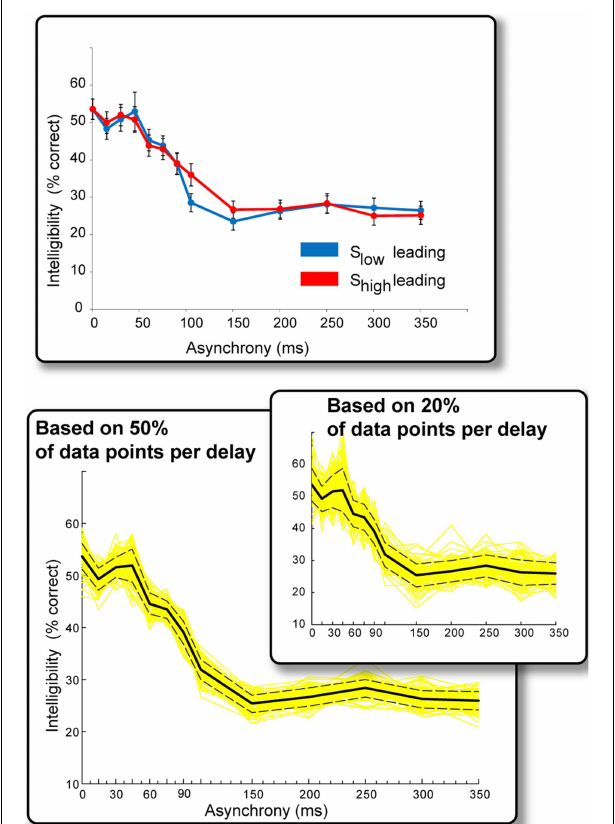
FIGURE 3 | Results of Experiment 2. Top: Intelligibility performance as a function of onset asynchrony. The “S low leading” and “S high leading” conditions resulted in qualitatively similar performance and data were therefore collapsed across the two conditions in subsequent analyses. Bottom: Solid black line: Intelligibility performance as a function of onset asynchrony (collapsed over ear of presentation and S high /S low leading). Performance can be divided into three intervals: Asynchronies < 45ms have no effect on intelligibility, performance declines sharply between 45 and 150ms, remaining constant beyond that interval. Yellow lines reflect repeated (100 iterations) computations of the above measure using random-subsets of 50% of the data points that contributed to each delay condition. Dashed lines are the standard error of the mean derived from this procedure. The inset presents the same analysis but over 20% of data points in each delay condition. The main effects are preserved in these analyses indicating that they are a stable